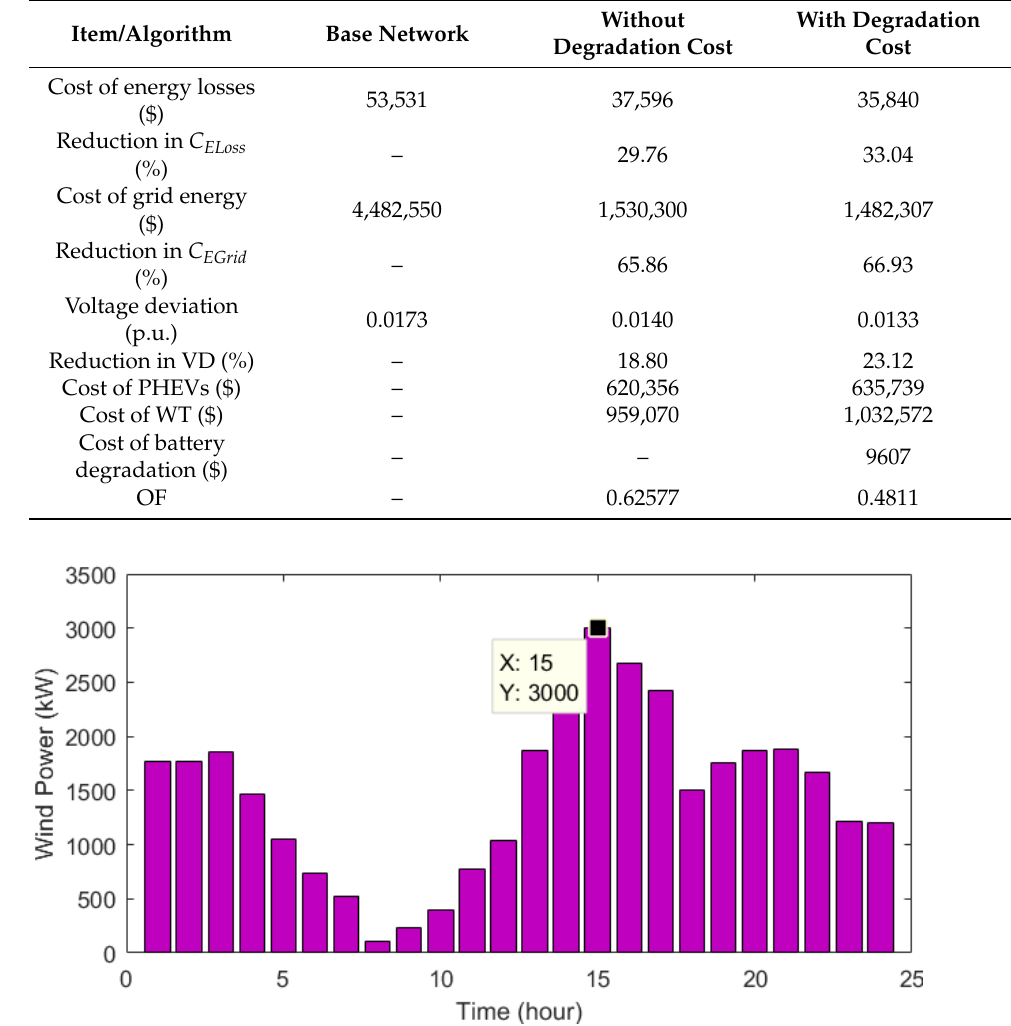
Figure 12. Wind power using the IGJO during 24 h with battery degradation cost.